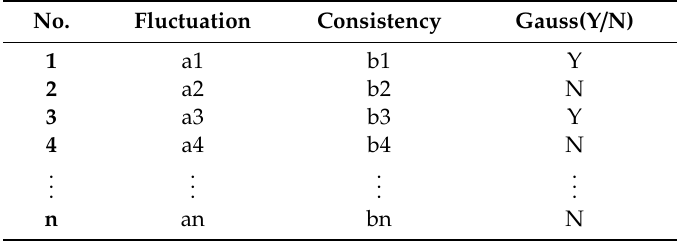
Table 1. The magnetic data sequence with di ff erent feature values and categories.